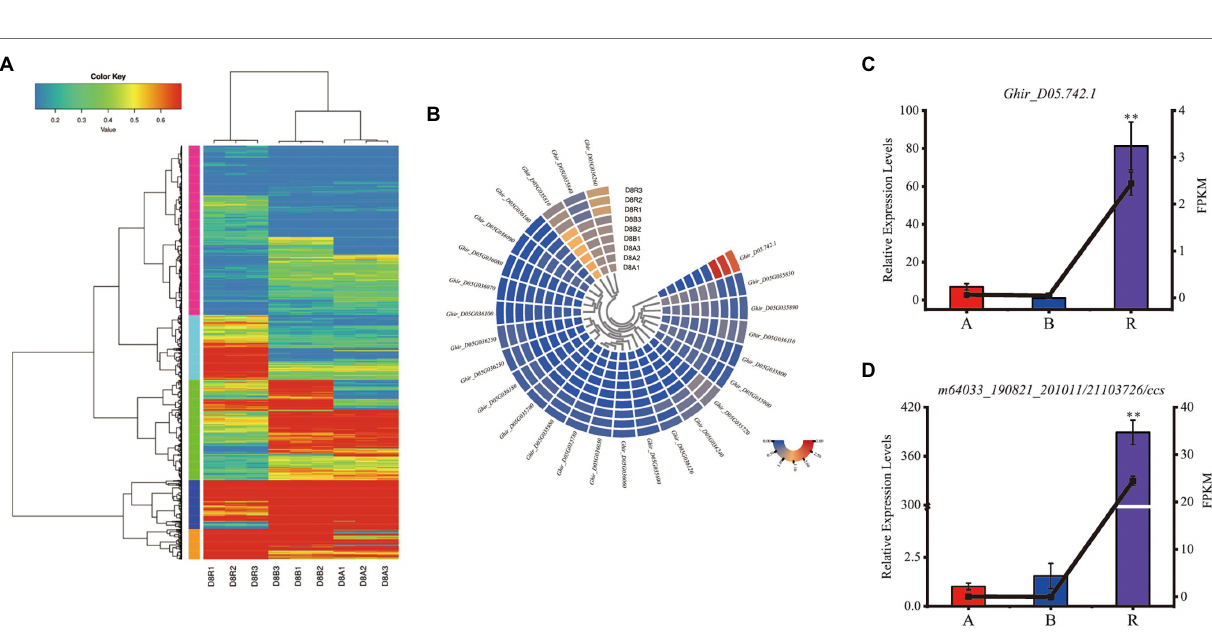
FIGURE 8 | The expression of DEGs. (A) Heat map of DEGs in R line compared with A line and B line. (B) Heat map of FPKM values of differentially expressed genes in candidate interval. A1, A2, A3: sterile line, B1, B2, B3: maintainer line, and R1, R2, R3: restorer line. (C) Expression patterns of Ghir_D05.742.1